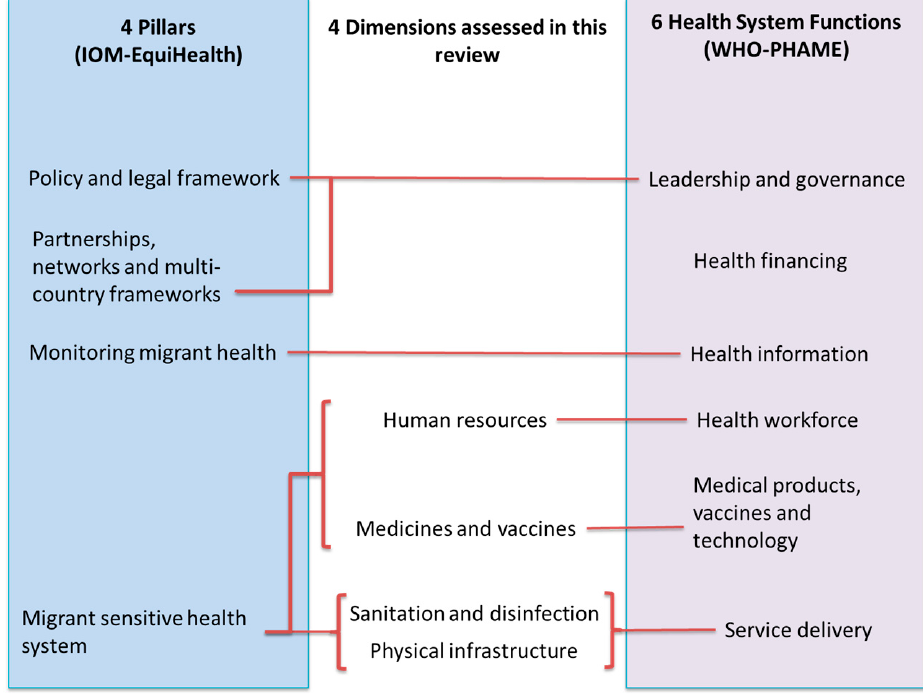
Figure 6. Assessment frameworks used in the International Organization for Migration (IOM) and World Health Organization (WHO) situation assessments in relation to the scoping review dimensions.